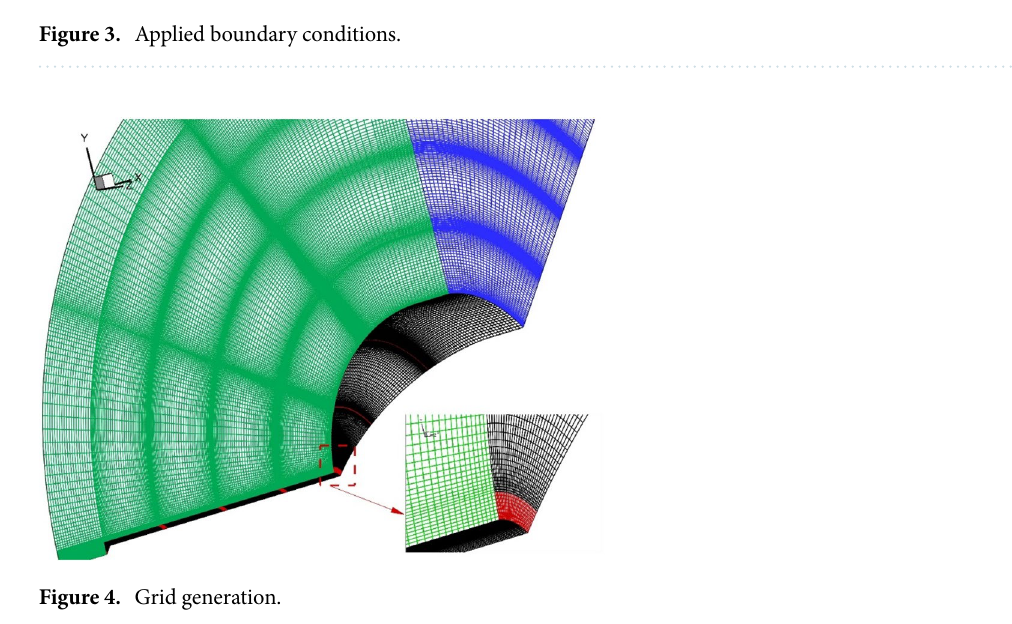
Figure 4. Grid generation.